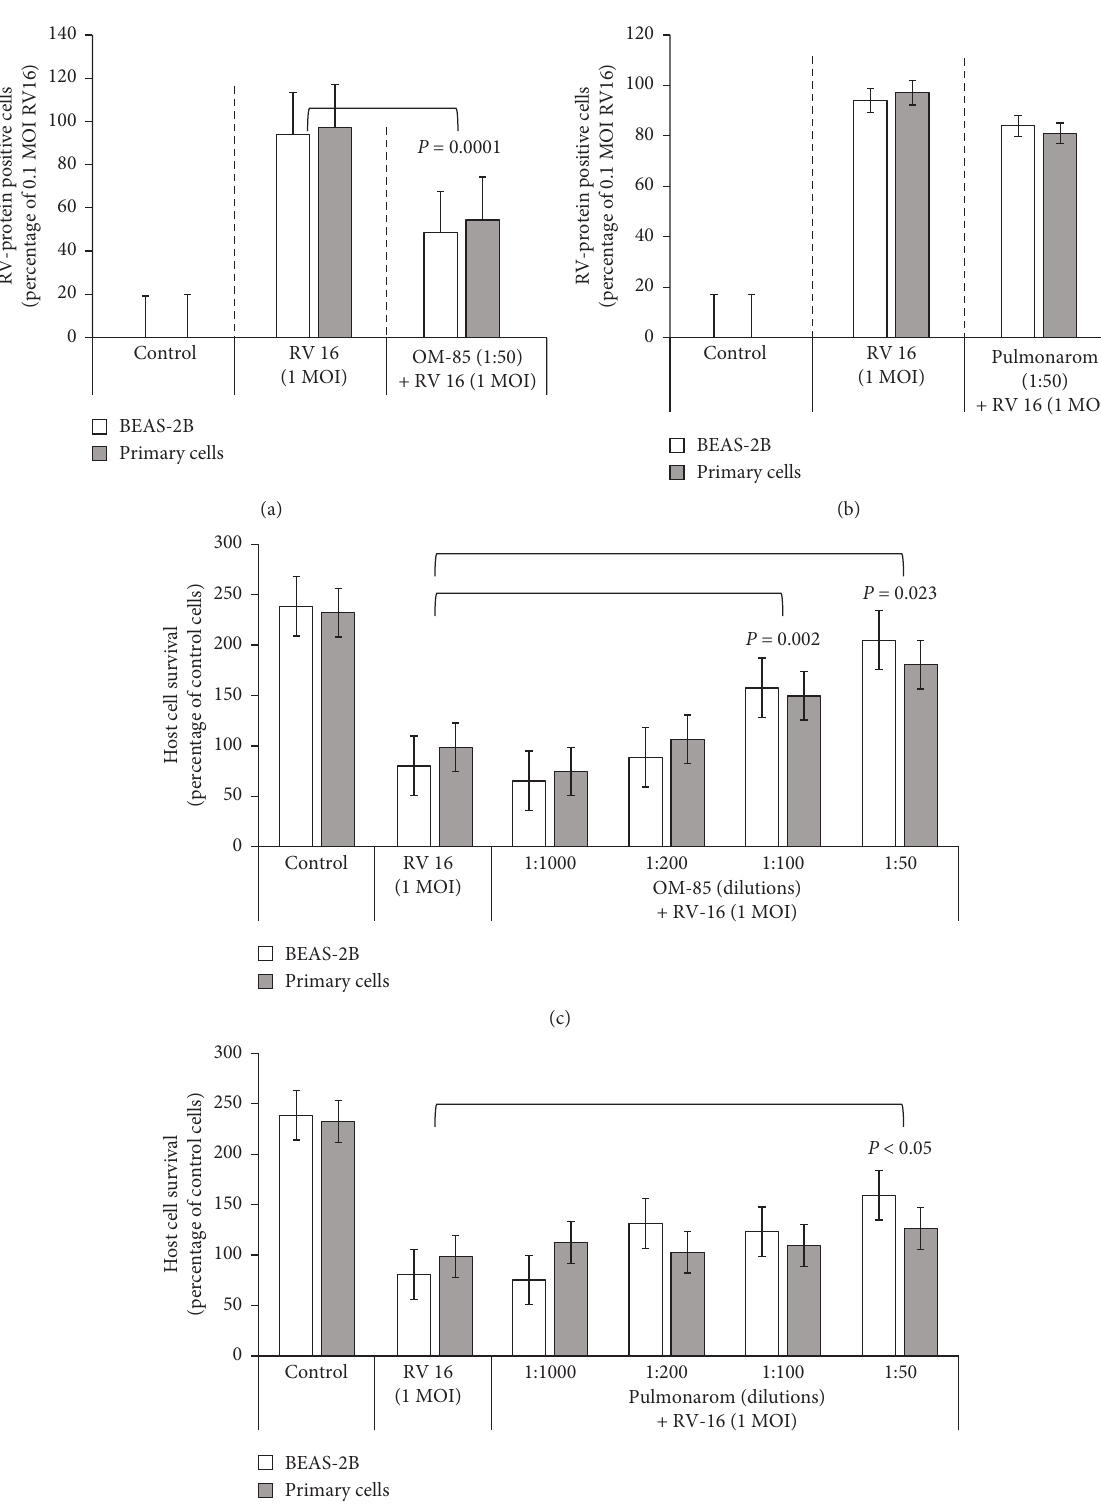
Figure 2: RV infection and RV-infected cells survival rates. The ratio of RV-16 positive BEAS-2B cells and primary human bronchial primary epithelial cells infected by 1.0 MOI RV-16 and pretreated with OM-85 (a) or Pulmonarom (b). Improved cell survival in 1.0 MOI RV-16-infected cultures pretreated with OM-85 (c) or Pulmonarom (d) at different dilutions (1:1000, 1:200. 1 :100, 1: 50). ICAM-1 expression and antiviral cytokine